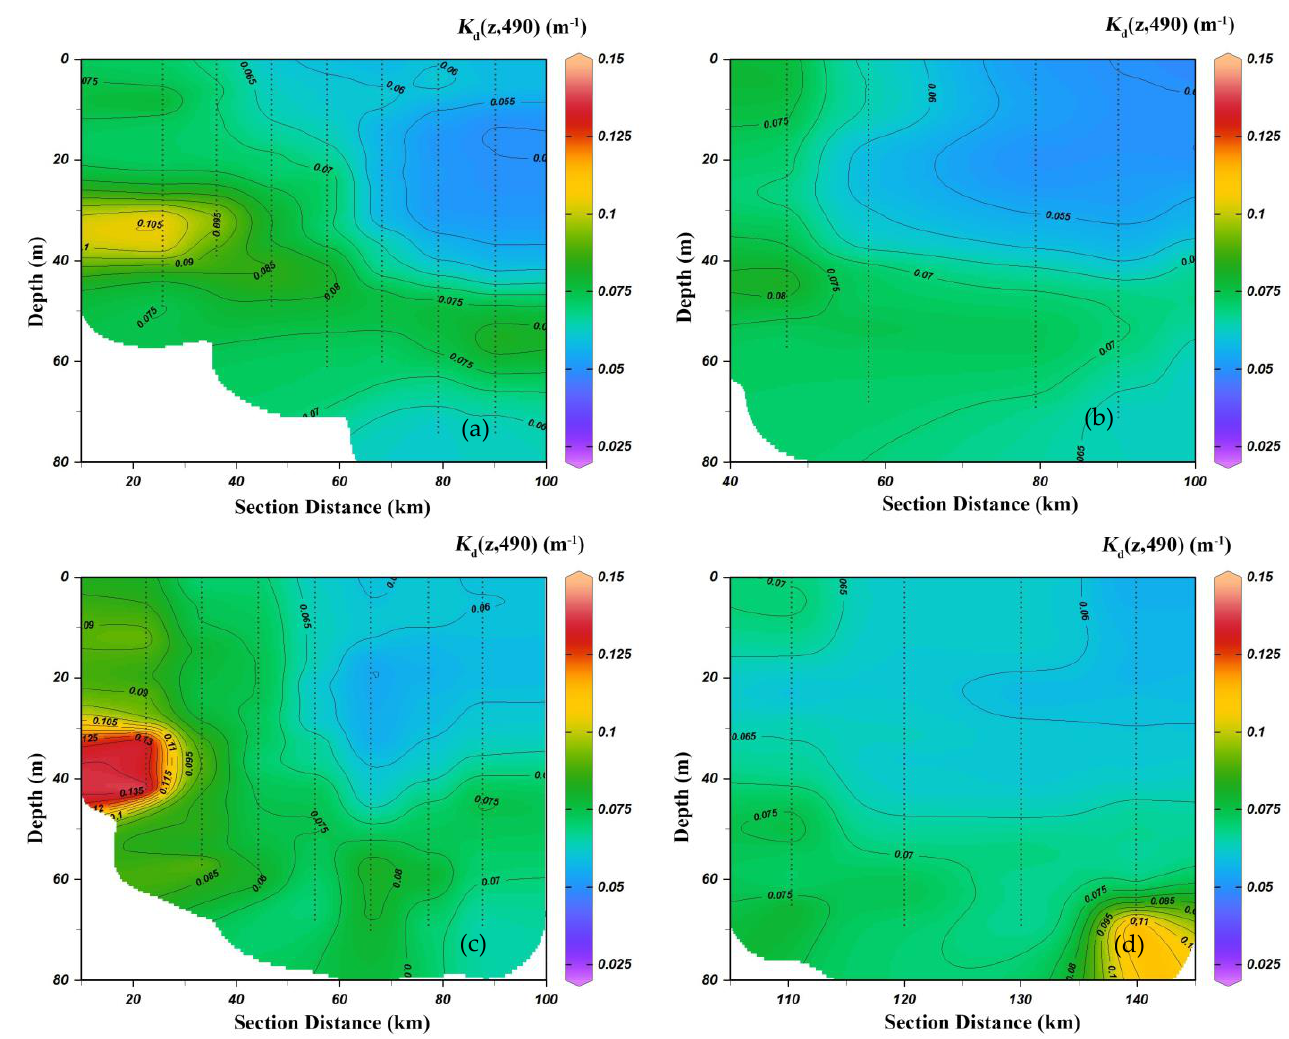
Figure 6. Vertical and horizontal distributions of 𝐾 𝑑 (𝑧, 490) in eastern Hainan Island: ( a ) Section a, ( b ) section b, ( c ) section c, and ( d ) section d.